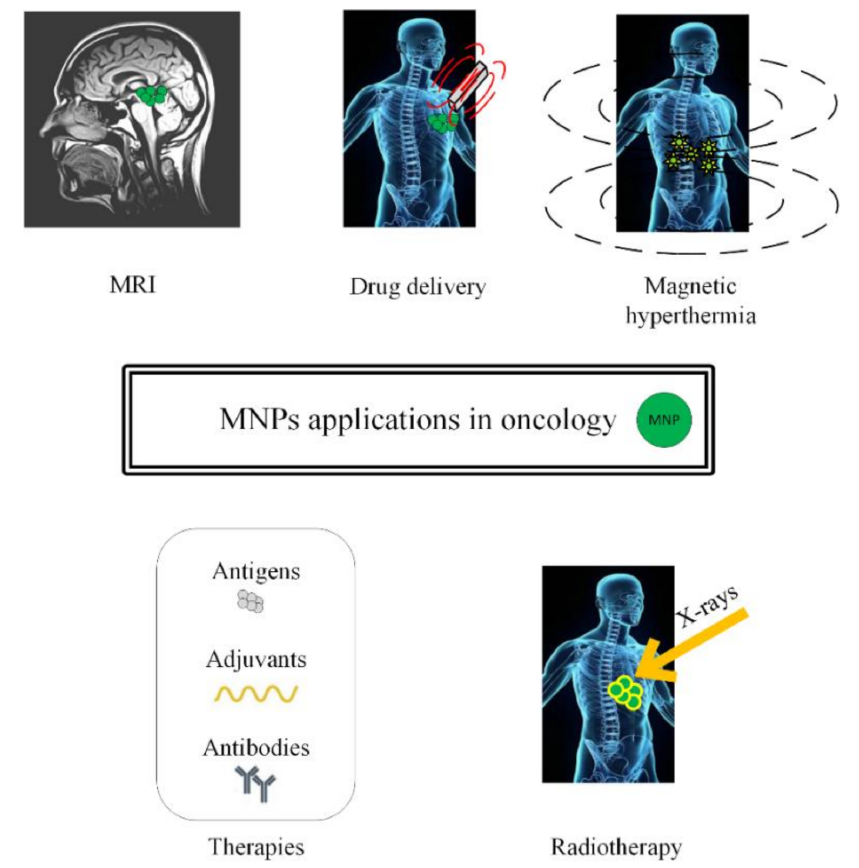
Figure 1. Schematic representation of magnetic nanoparticles’ applications in oncology (MRI investi- gations, drug delivery in chemotherapy, magnetic hyperthermia, immunotherapy and